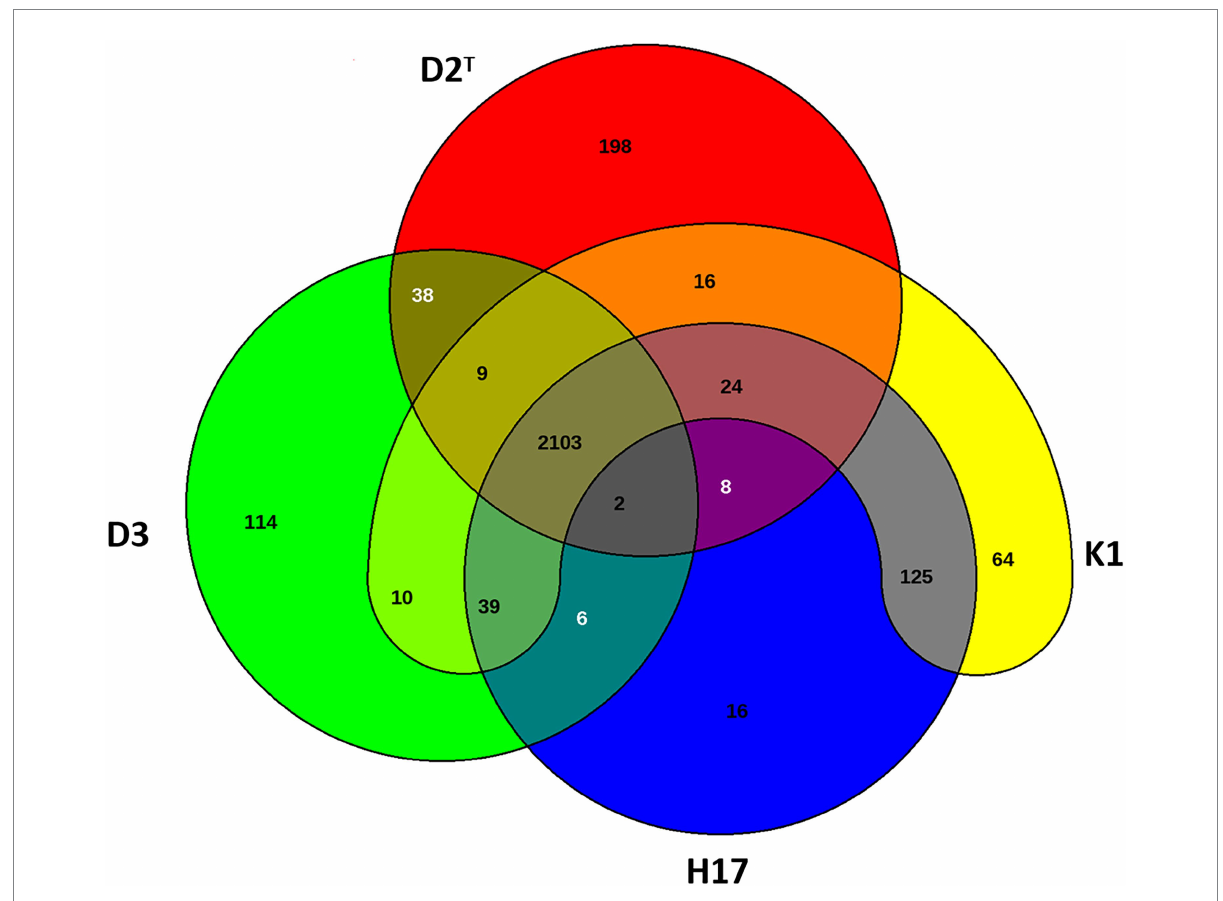
FIGURE 3 Venn diagram of shared genes and singletons of type strain D2 T (red), ISS isolate K1 (yellow), bedrest-study isolate H17 (blue) and clean room isolate D3 (green).